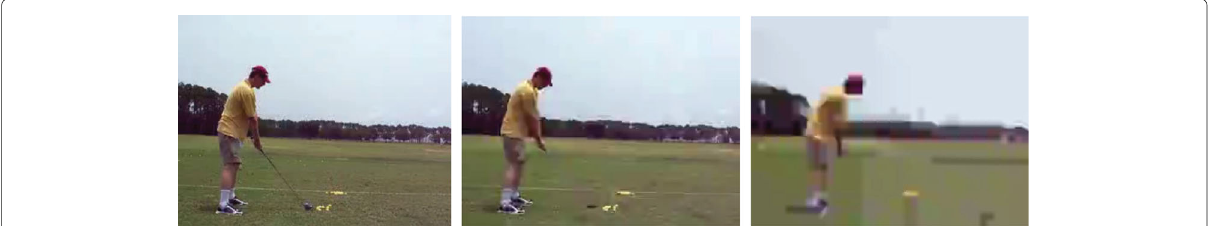
Fig. 3 Sample video frame with different constant rate factors (crf). Left: crf 29, center: crf 38, right: crf 50. Note the adverse deterioration in quality when video is